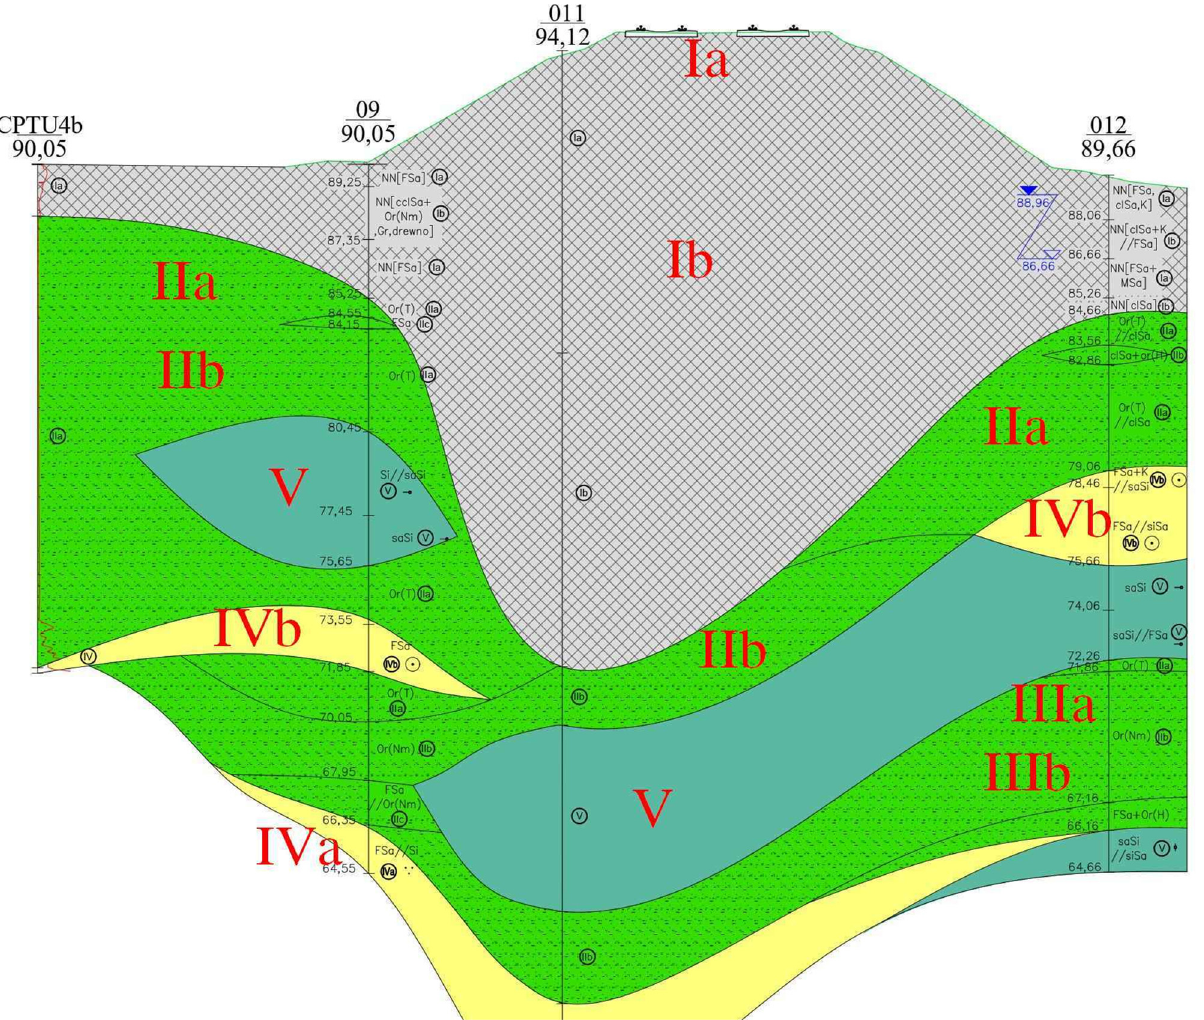
Figure 11: Geotechnical cross section through the embankment and its foundation. The depth of the tests exceeded 30 m. Green denotes organic soils, grey – anthropogenic soils, yellow – non - cohesive soils, and blue – cohesive